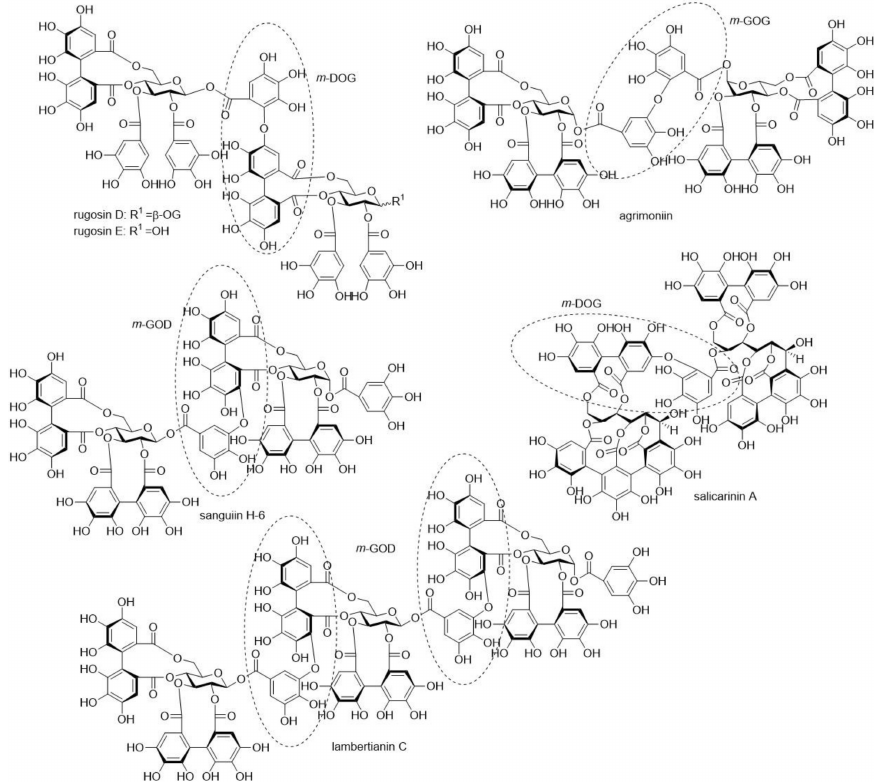
Figure 2. Structures of oligomeric ellagitannins utilised in this